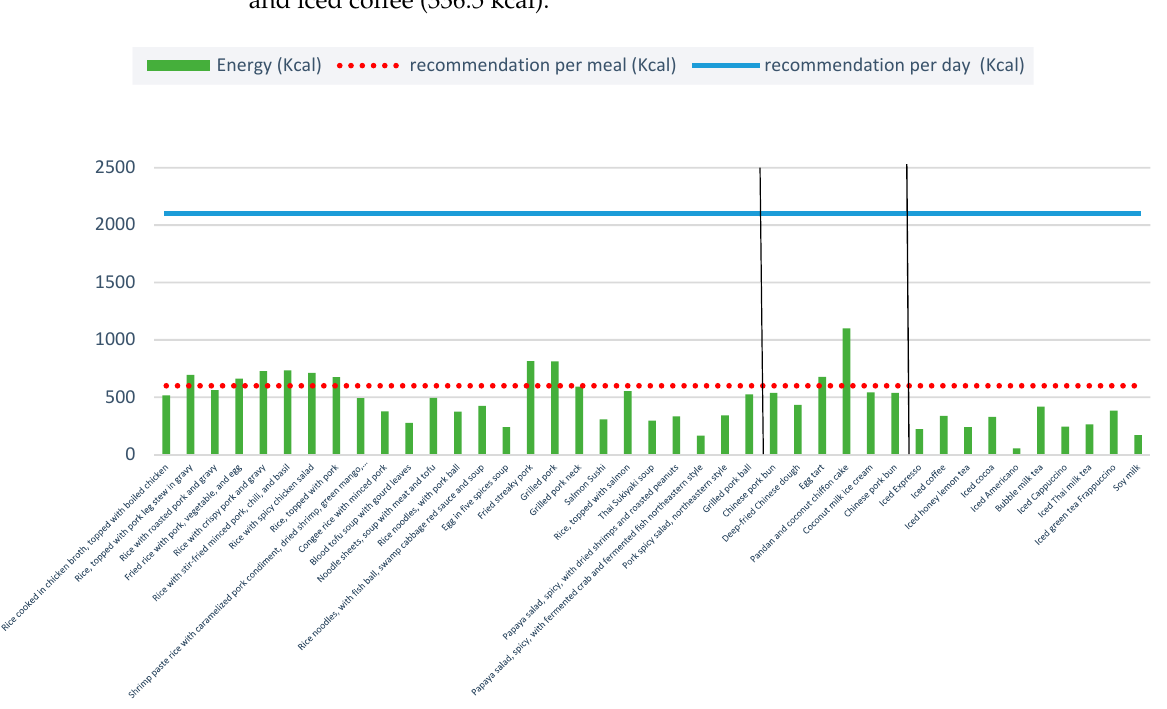
Figure 2. Total energy content per portion of the 40 menu items. Note: Two vertical blacks line separate the three food types: ready-to-eat items, sweets, and non-alcoholic beverages.